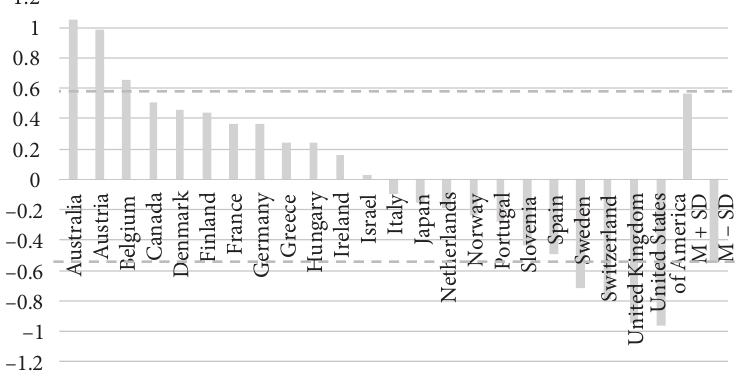
Figure 3. Individual effects for the NTEA exploratory model